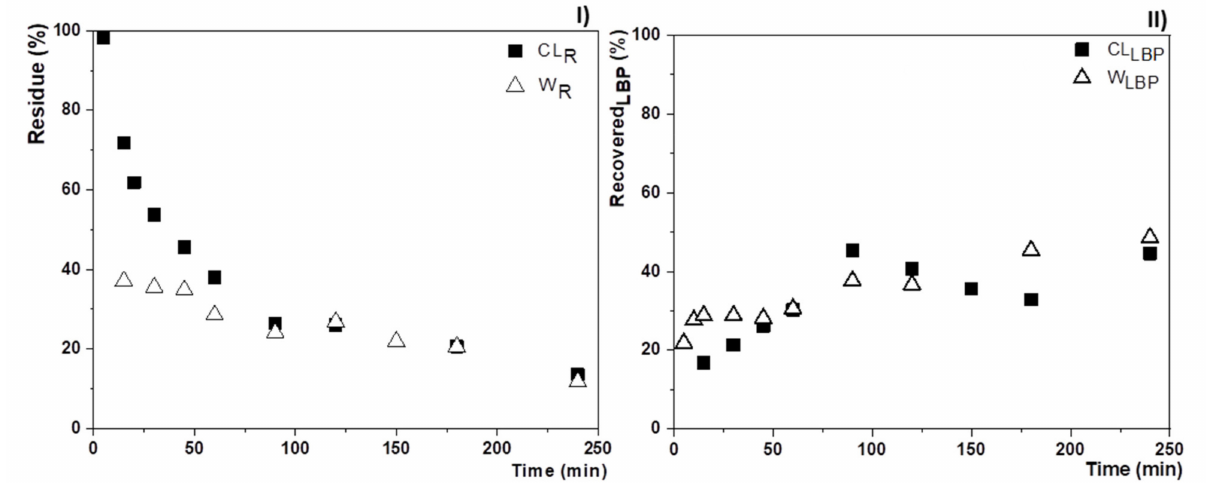
Figure 2. Percentage of ( I ) the residue obtained during CL (CL R ) and wood liquefaction (W R ), and ( II ) the “lignin-based polymer” recovered during CL (CL LBP ) and wood liquefaction (W LBP ) with